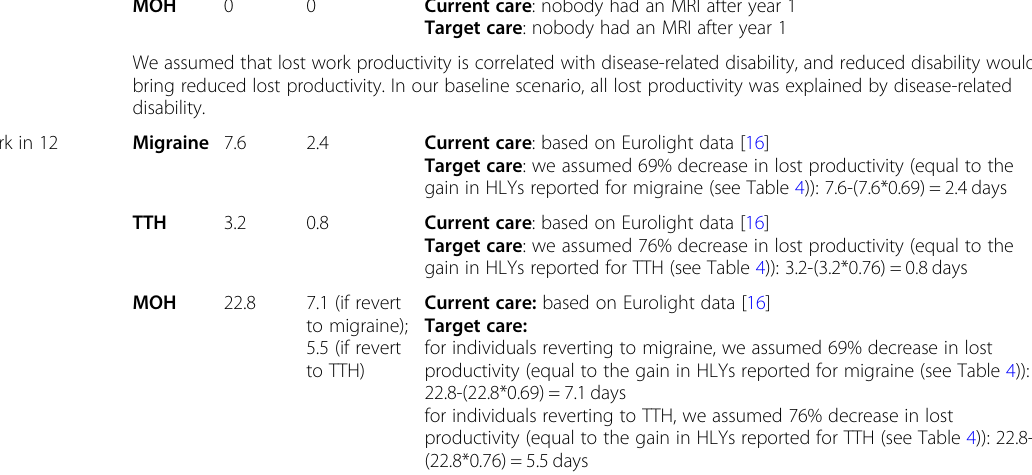
Results Here we set out results for the three countries in terms of headache-related costs (including use of health-care resources and lost productivity) and health outcomes (HLYs) attached to each alternative (current vs target care) only to demonstrate how the models worked. Analyses of the differences in costs and health outcomes between alternatives and the incremental cost-effectiveness ratios are presented elsewhere [15].